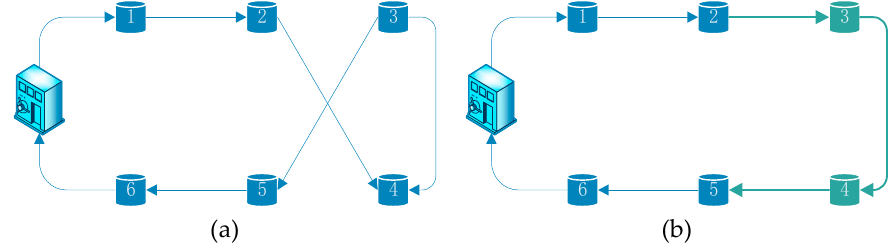
Figure 3. Reverse operation. ( a ) Route before reverse operation and ( b ) route after reverse operation.